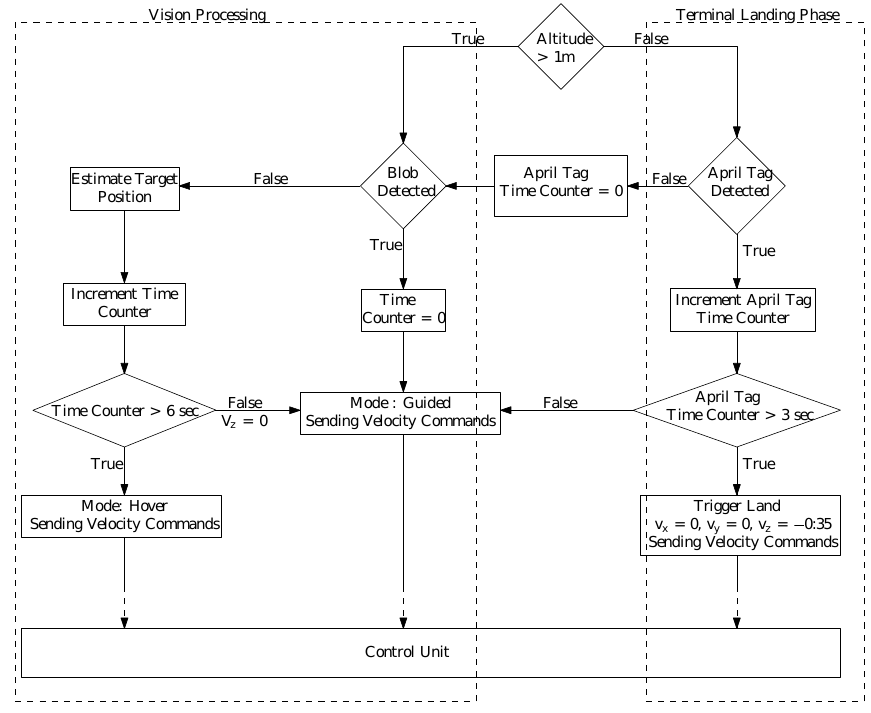
Figure 11. Vision and control pipeline for autonomous